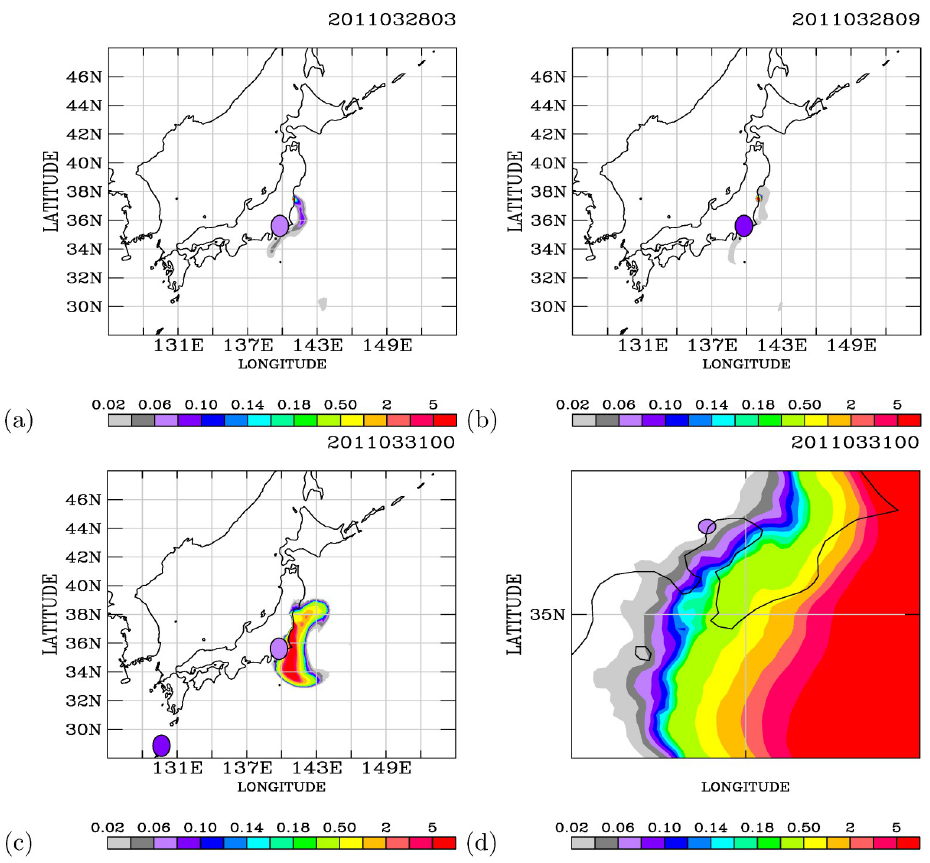
Fig 12. The same as in Fig 11 but comparing the model simulations with the observed air dose rates at 03 UT on 28 March ((a), (b)) and at 09 UT on 28 March ((c), (d)). Map made with Natural Earth. Free vector and raster map data at